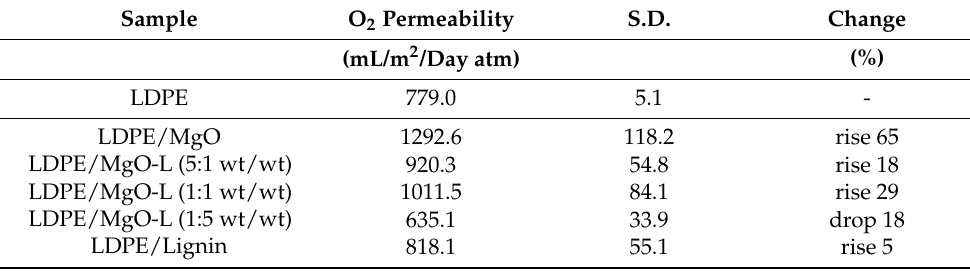
Table 3. Oxygen transmission rate (OTR) of neat LDPE film and composite films.